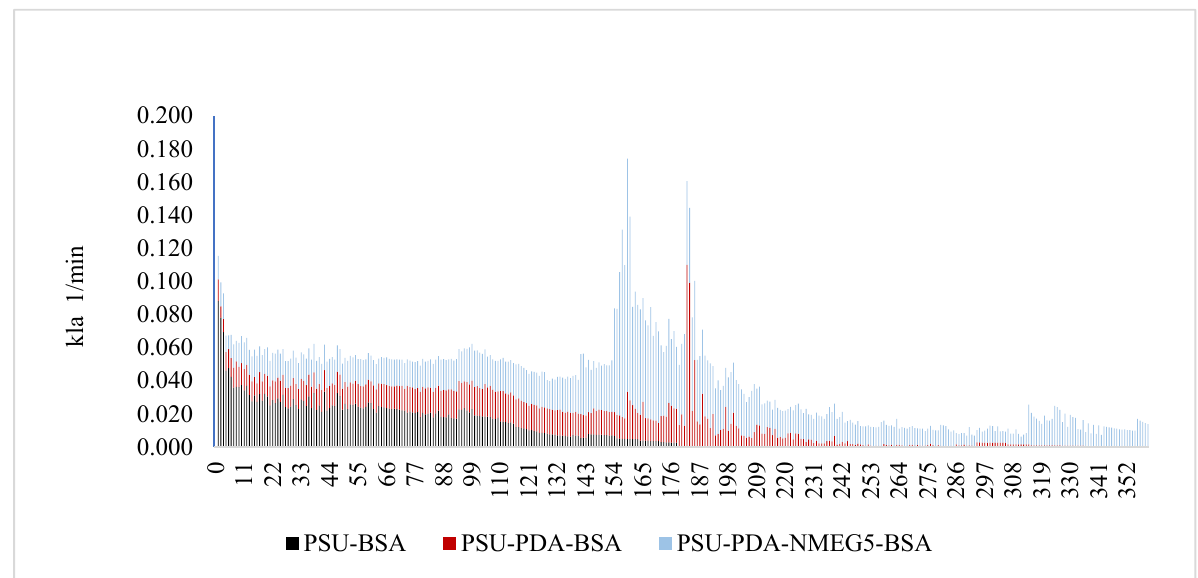
Figure 3. Oxygen transfers coefficients for unmodified and modified fibers over time. Overall, results indicate that modified HFMs, both PSU-PDA and PSU-PDA-NMEG5-BSA-35, have higher oxygen transfer coefficients and undergo less fouling compared to unmodified HFMs (PSU-BSA-35). Oxygen transfer rates were maintained for longer periods of time in peptoid HFMs compared to polydopamine HFMs (Table 1). The highest kLa values were observed in the case of the PSU-PDA-NMEG5-BSA membrane (0.19 ± 0.14 min − 1 ). This was followed by the PSU-PDA-BSA membrane where kLa values of 0.11 ± 0.22 min − 1 were achieved. kLA values for PSU-BSA was the minimum (0.088 ± 0.11 min − 1 ). Moreover, both fibers of (PSU-BSA- 35 mg/mL) and (PSU-PDA- BSA35 mg/mL) were blocked and oxygen transfer completely stopped at 3 h for PSU-BSA and 6 h for PSU-PDA-BSA membranes. On the other hand, PSU-PDA-NMEG5 was resistant to protein fouling for 6 h; the kLa value at 6 h was observed to be 0.014 ± 0.008 min −